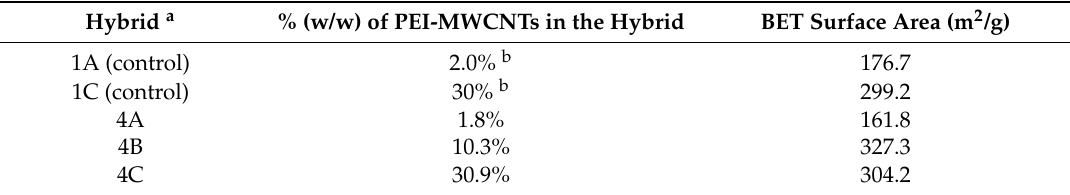
Table 3. Hybrid nanocomposites preparation.